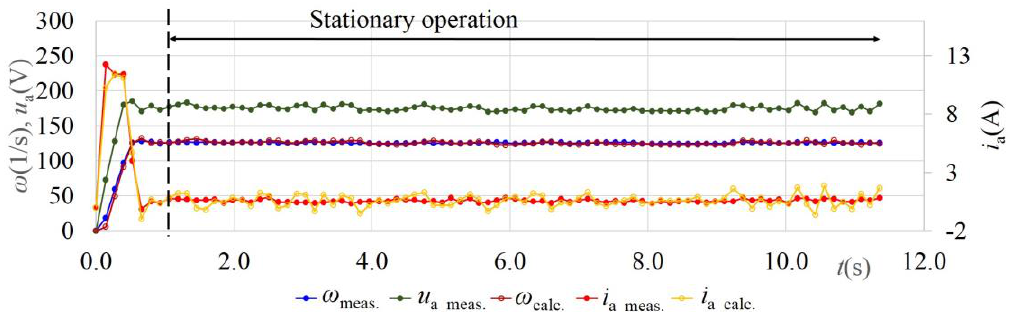
Figure 16. The whole measured and calculated values using RK for MD1.